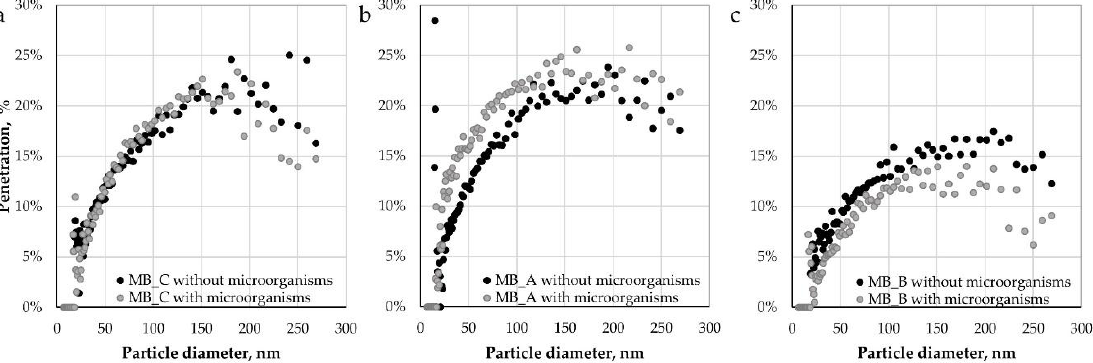
Figure 7. Penetration of nanoparticles and submicron particles through: ( a ) Control MB nonwovens, ( b ) MB nonwovens with dust A, and ( c ) MB nonwovens with dust B.